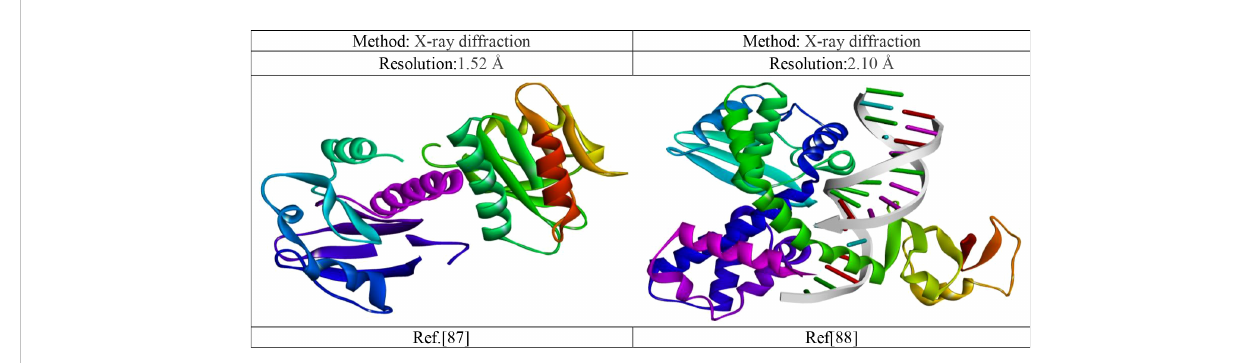
FIGURE 6 Experimental three-dimensional protein structures information (Minasov et al., 2022; Perry et al.,